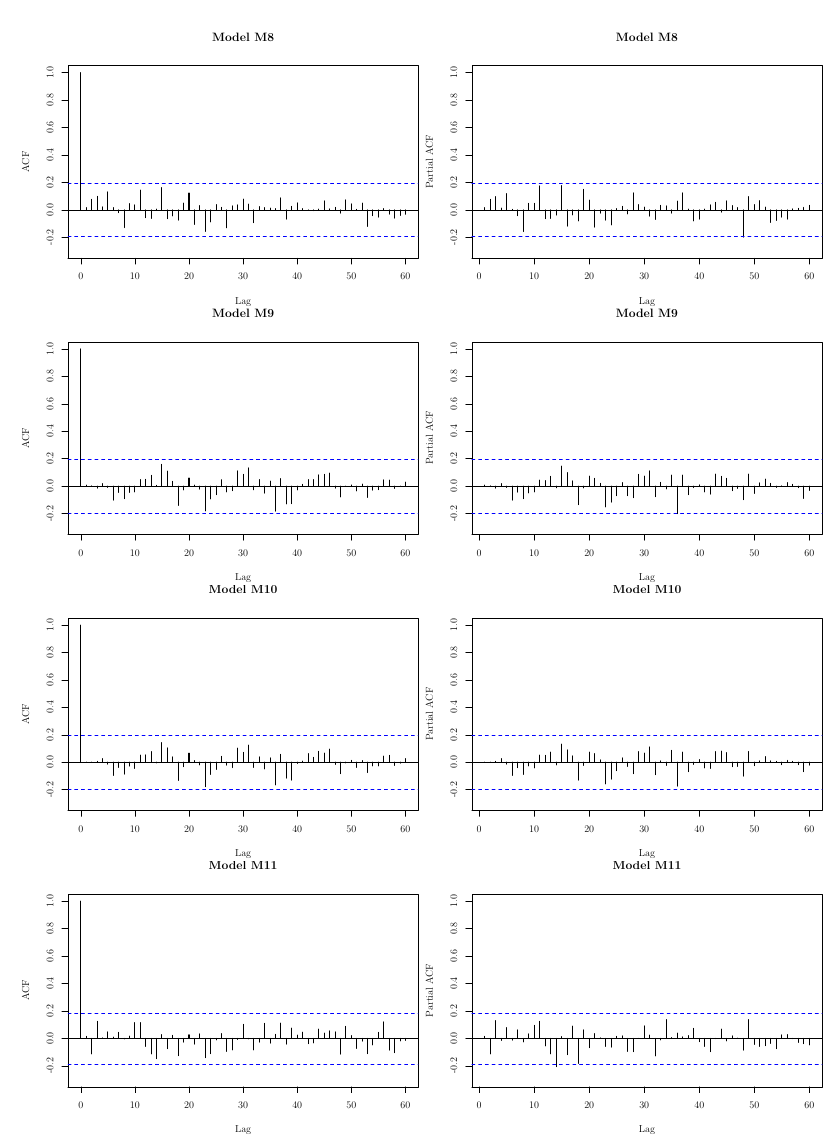
Figure 15 – Correlograms of the residuals from models M8 – M11 fit for the time series of Canadian